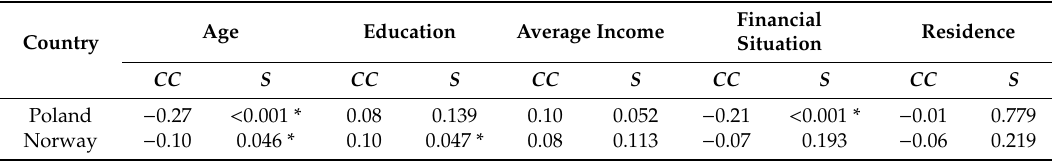
Table 3. Situation variables x PA